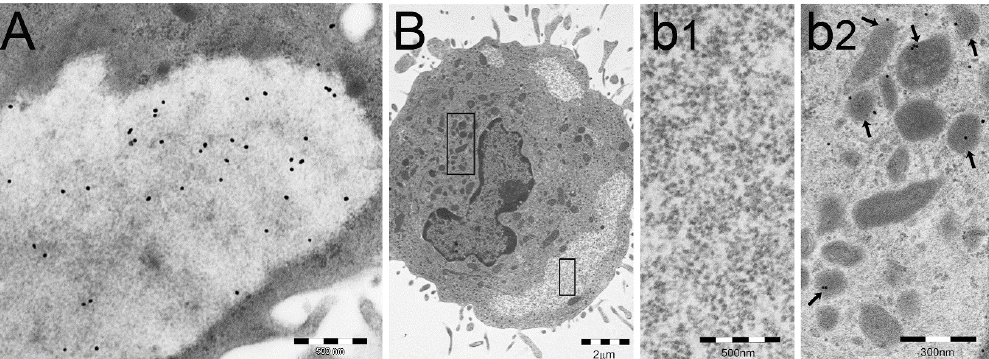
Figure 2. PaCSs store polyubiquitinated proteins (pUbPs) of non-K63-linked type. ( A , B ) Human dendritic cells (DCs) differentiated in vitro through GM-CSF plus IL-4 treatment, followed by LPS-induced maturation. In ( A ), PaCS shows immunoreactivity for the FK1 antibody, directed against pUbPs. In ( B ), another human DC from the same preparation shows three PaCSs, one of which (boxed) is enlarged in ( b1 ) to illustrate its unreactivity for the anti-K63-linked pUbPs antibody, which, however, reacts with some juxtanuclear late endosomal bodies (left box in ( B ), enlarged in ( b2 ): see arrows). ( B ) is reproduced and adapted from Reference [26], under Creative Commons Attribution (CC BY 4.0) International Licenses.